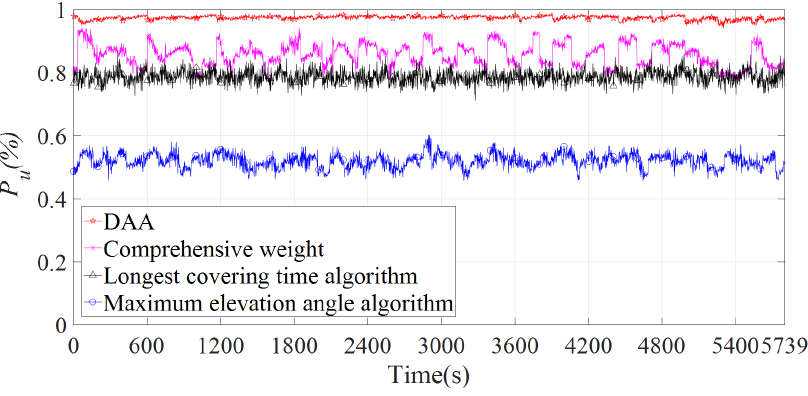
Figure 10. Coverage time utilization with different access